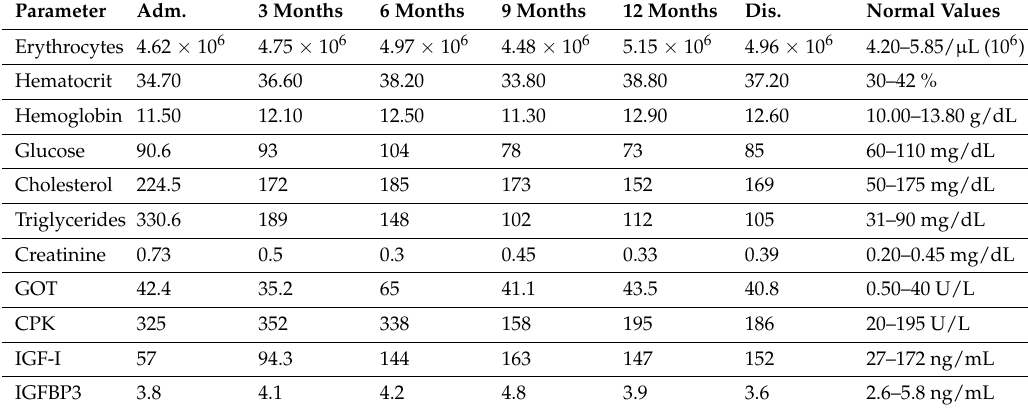
Table 1. Main plasma values (hematology, biochemistry, hormones) at admission (Adm.) and at 3-month intervals after beginning the treatments and at discharge (Dis.), and normal values for the age of the patient. Note that at admission, total cholesterol, triglycerides, creatinine, GOT (aspartate aminotransferase) and CPK (creatine phosphokinase) were at values over the upper limit of normality. Plasma cholesterol and creatinine already had normal values after the first 3 months of treatment, while GOT after decreasing after 3 months of treatment, again increased 3 months later and remained slightly elevated until discharge. This was most likely due to high levels of triglycerides in plasma which were always higher than normal values due to high caloric intake at the expense of fatty foods with which his mother fed him. At admission, the plasma CPK had high values, probably due to the existing spasticity, but 9 months after starting the treatment it was already at normal values. Thyroid hormones and cortisol were always at normal values (data not shown). IGF-I: